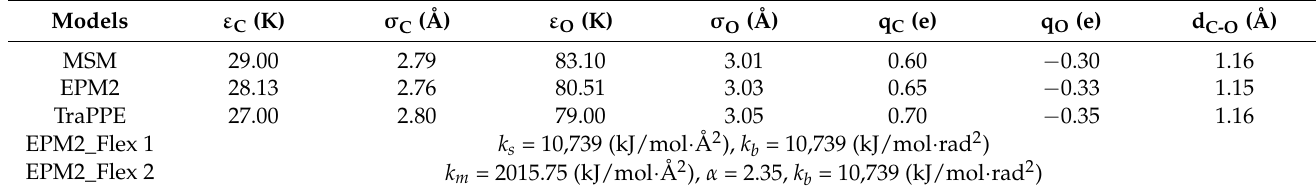
Table 3. Parameters of potential models used in CO 2 Molecular dynamics